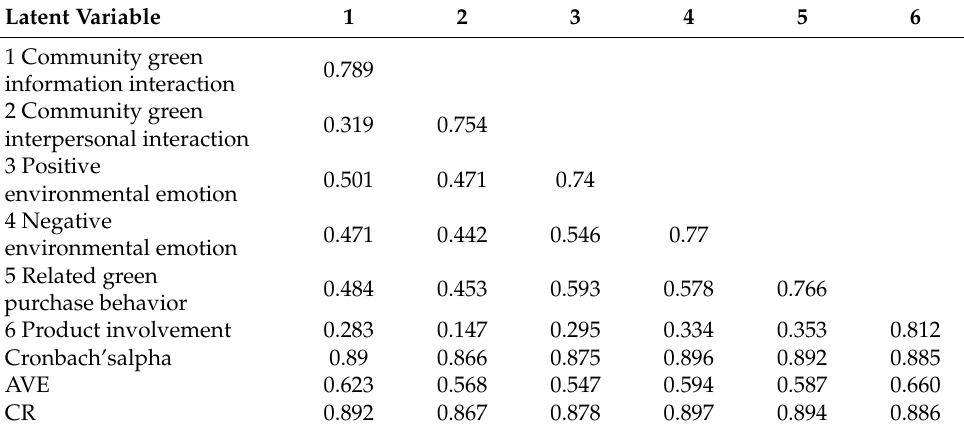
Table 3. Analysis results of correlation coefficient, reliability and discriminant